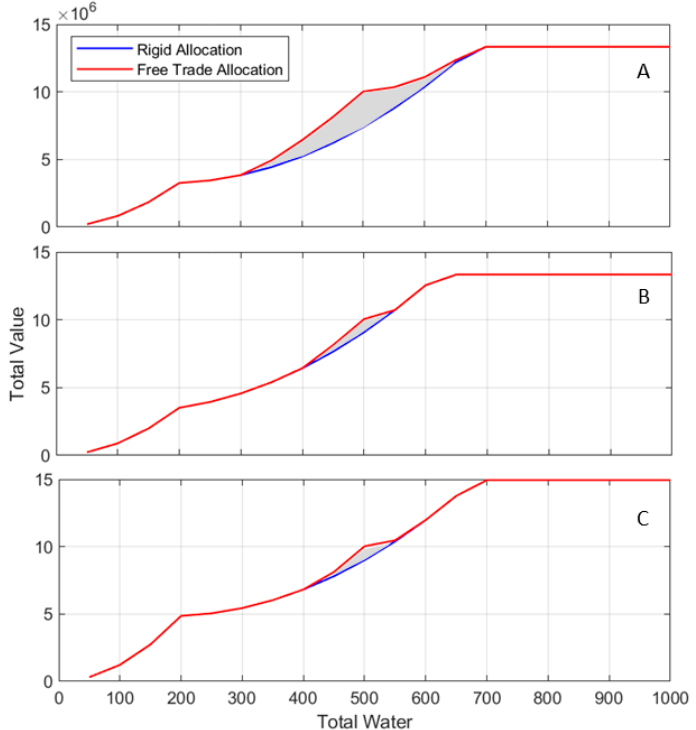
Figure 6. Comparison of attainable economic output under free trade scenarios (red) vs. a scenario in which the upstream user focuses only on maximizing its own output (blue) when the higher valued industrial user is upstream. ( A ) WTP ratio of 2:1, industrial return flow 10%. ( B ) WTP ratio of 2:1, industrial return flow 40%. ( C ) WTP ratio of 3:1, industrial return flow 10%.